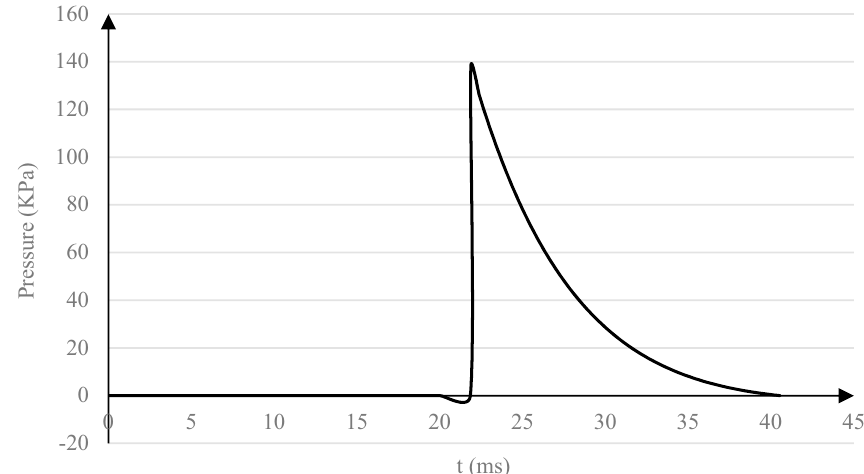
Figure 1. Overpressure time history of a 500 kg TNT explosion, 20 m above the ground surface.